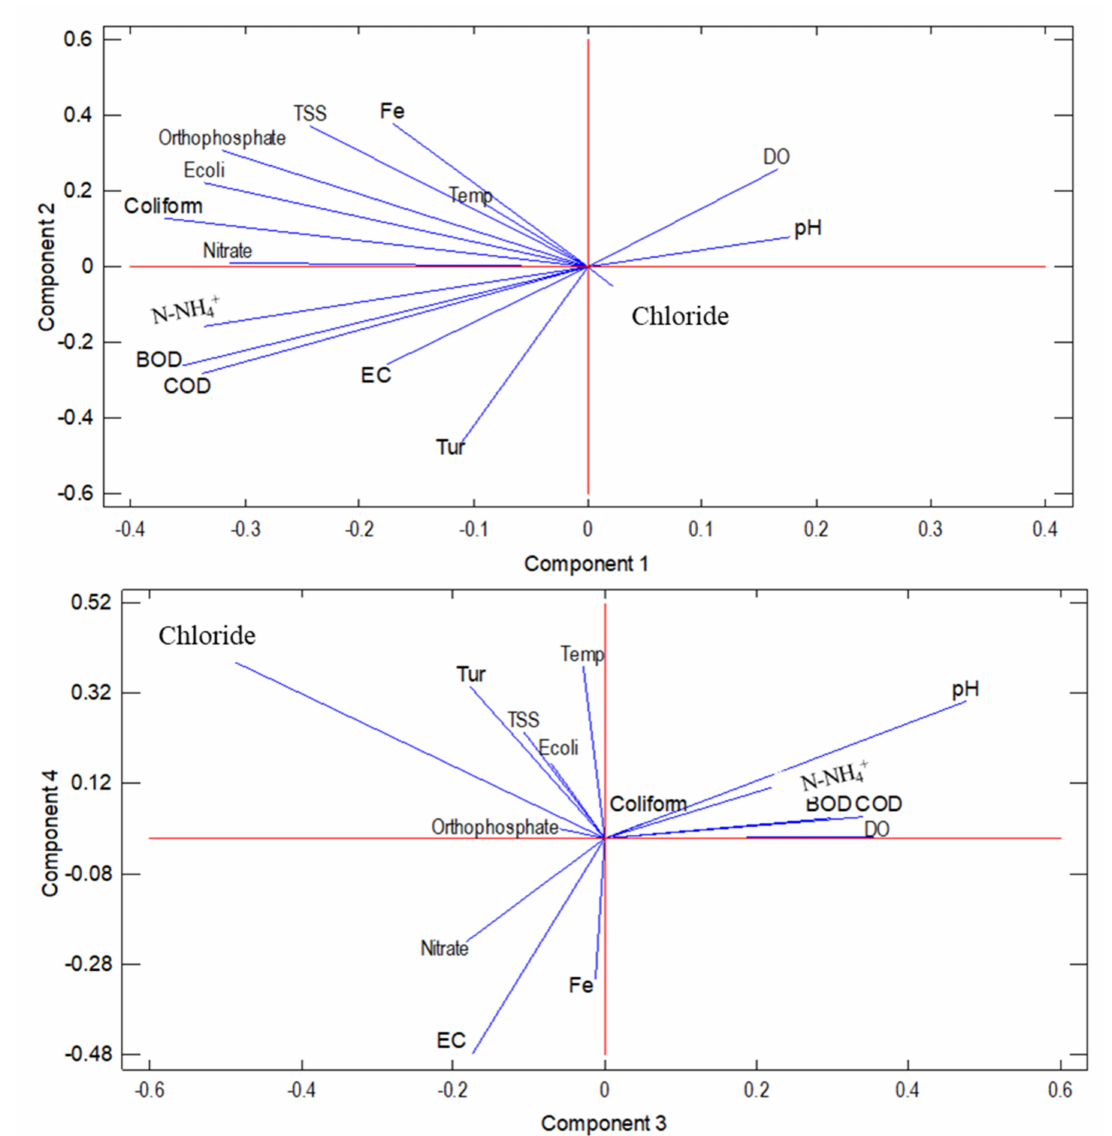
Figure 8. Key variables influencing surface water quality in the study